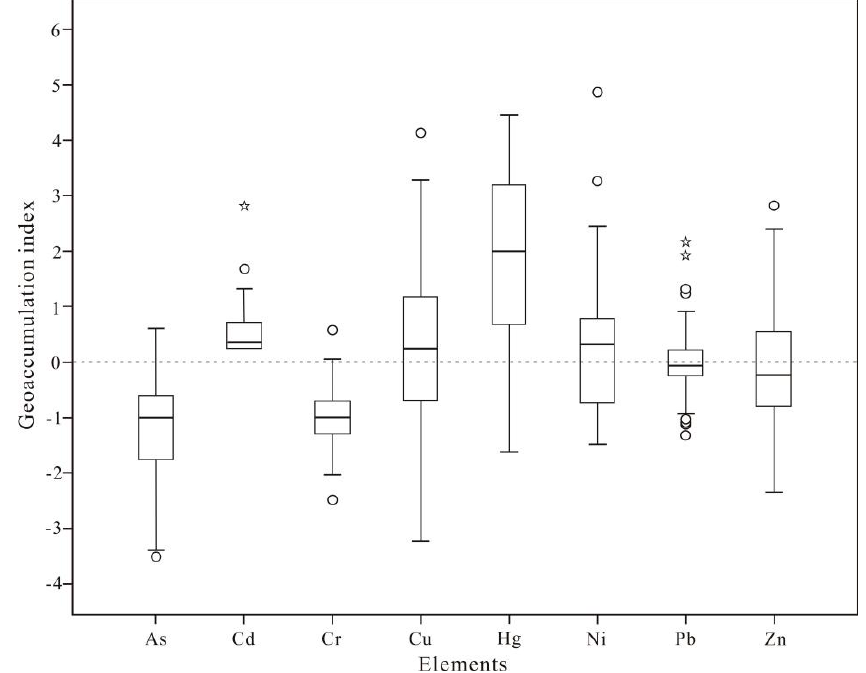
Figure 3. Box plot of I geo for heavy metals in topsoils around industrial sites in Dongguan. The circles represent outliers (mild outliers), and the stars represent extremes (extreme outliers). The horizontal lines at the top, middle and bottom of the box plot correspond to the 75th percentile, median and 25th percentile, respectively .